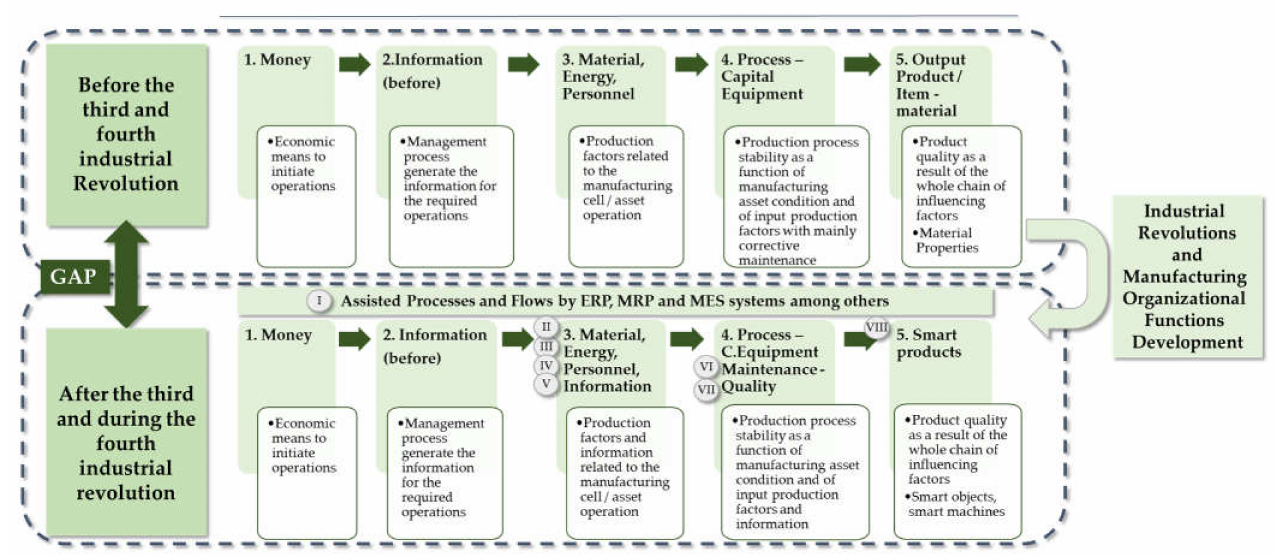
Figure 4. Conceptual framework for functional improvement potentials over the industrial revolu- tions (the authors’ own